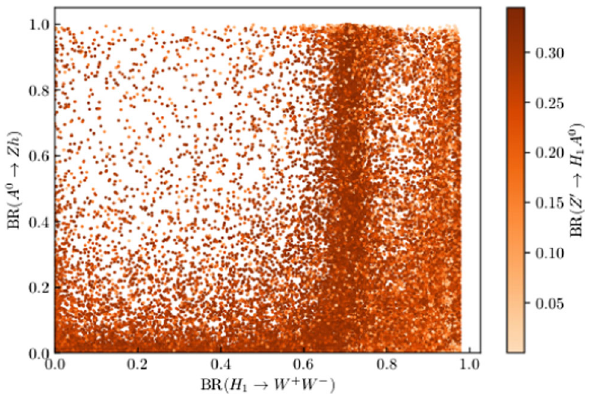
Fig. 7 Branching ratios for A 0 → Zh versus versus H 1 → WW resulting from the parameter space scan in scenario 3. The colour grad- ing is related to the value of BR ( Z (cid:2) → H 1 A 0 ) as shown on the right